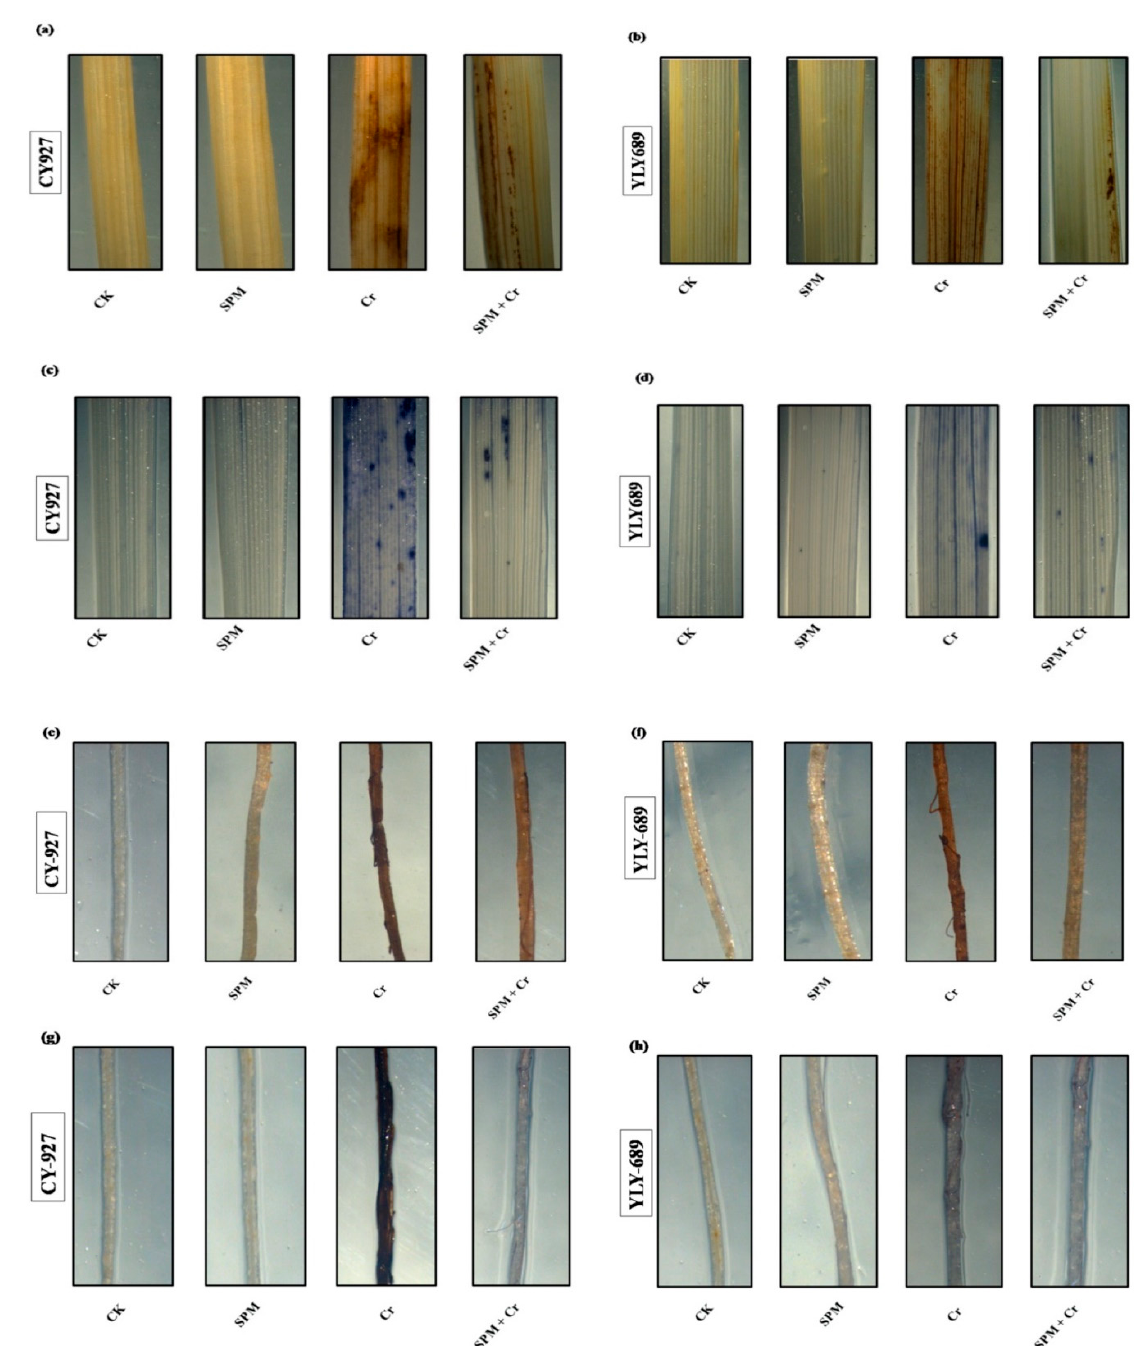
Figure 3. Effects of seed primed SPM on histochemical staining to identify the accumulation of ( a ) hydrogen peroxide (H 2 O 2 ) in the shoots of CY927, and ( b ) hydrogen peroxide (H 2 O 2 ) in the shoots of YLY689 by 3,3-diaminobenzidine (DAB), ( c ) superoxide (O 2• ‒ ) in the shoots of CY927, and ( d ) superoxide (O 2• ‒ ) in the shoots of YLY689 by nitro blue tetrazolium (NBT), ( e ) hydrogen peroxide (H 2 O 2 ) in the roots of CY927, and ( f ) hydrogen peroxide (H 2 O 2 ) in the roots of YLY689 by 3,3-diaminobenzidine (DAB), ( g ) superoxide (O 2• ‒ ) in the roots of CY927, ( h ) superoxide (O 2• ‒ ) in the roots of YLY689 by nitro blue tetrazolium (NBT).